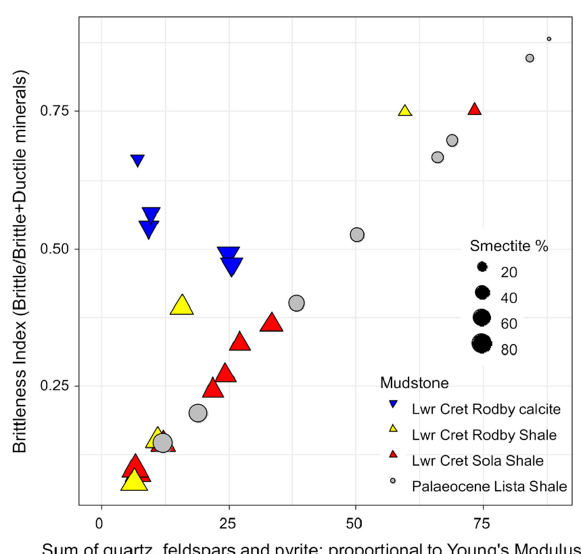
Figure 19. Comparison of SEM-EDS data in terms of pseudo-functions that relate to various geomechanical parameters. The sizes of all symbols represents the quantity of smectite. Diagram